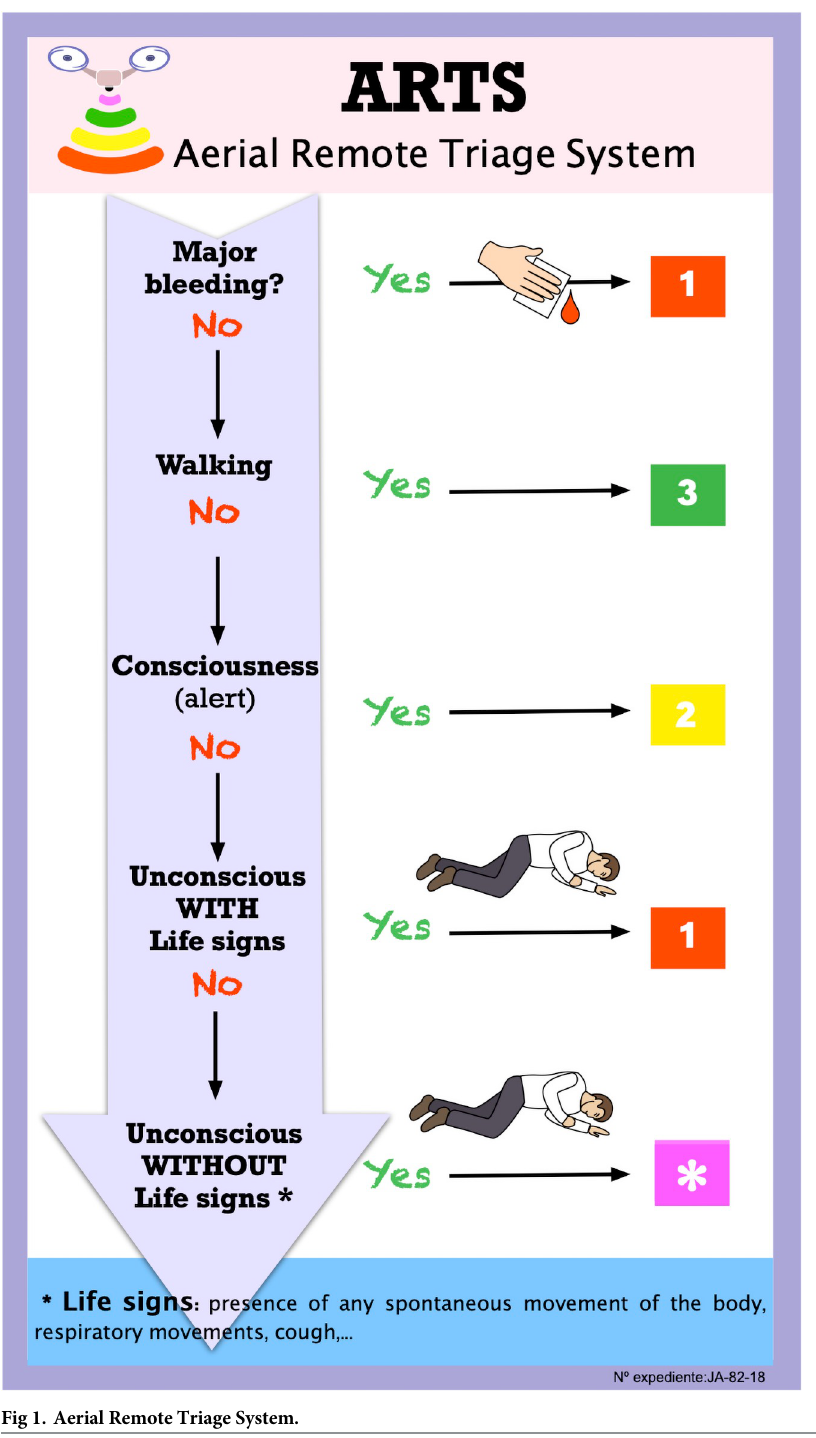
Fig 1. Aerial Remote Triage